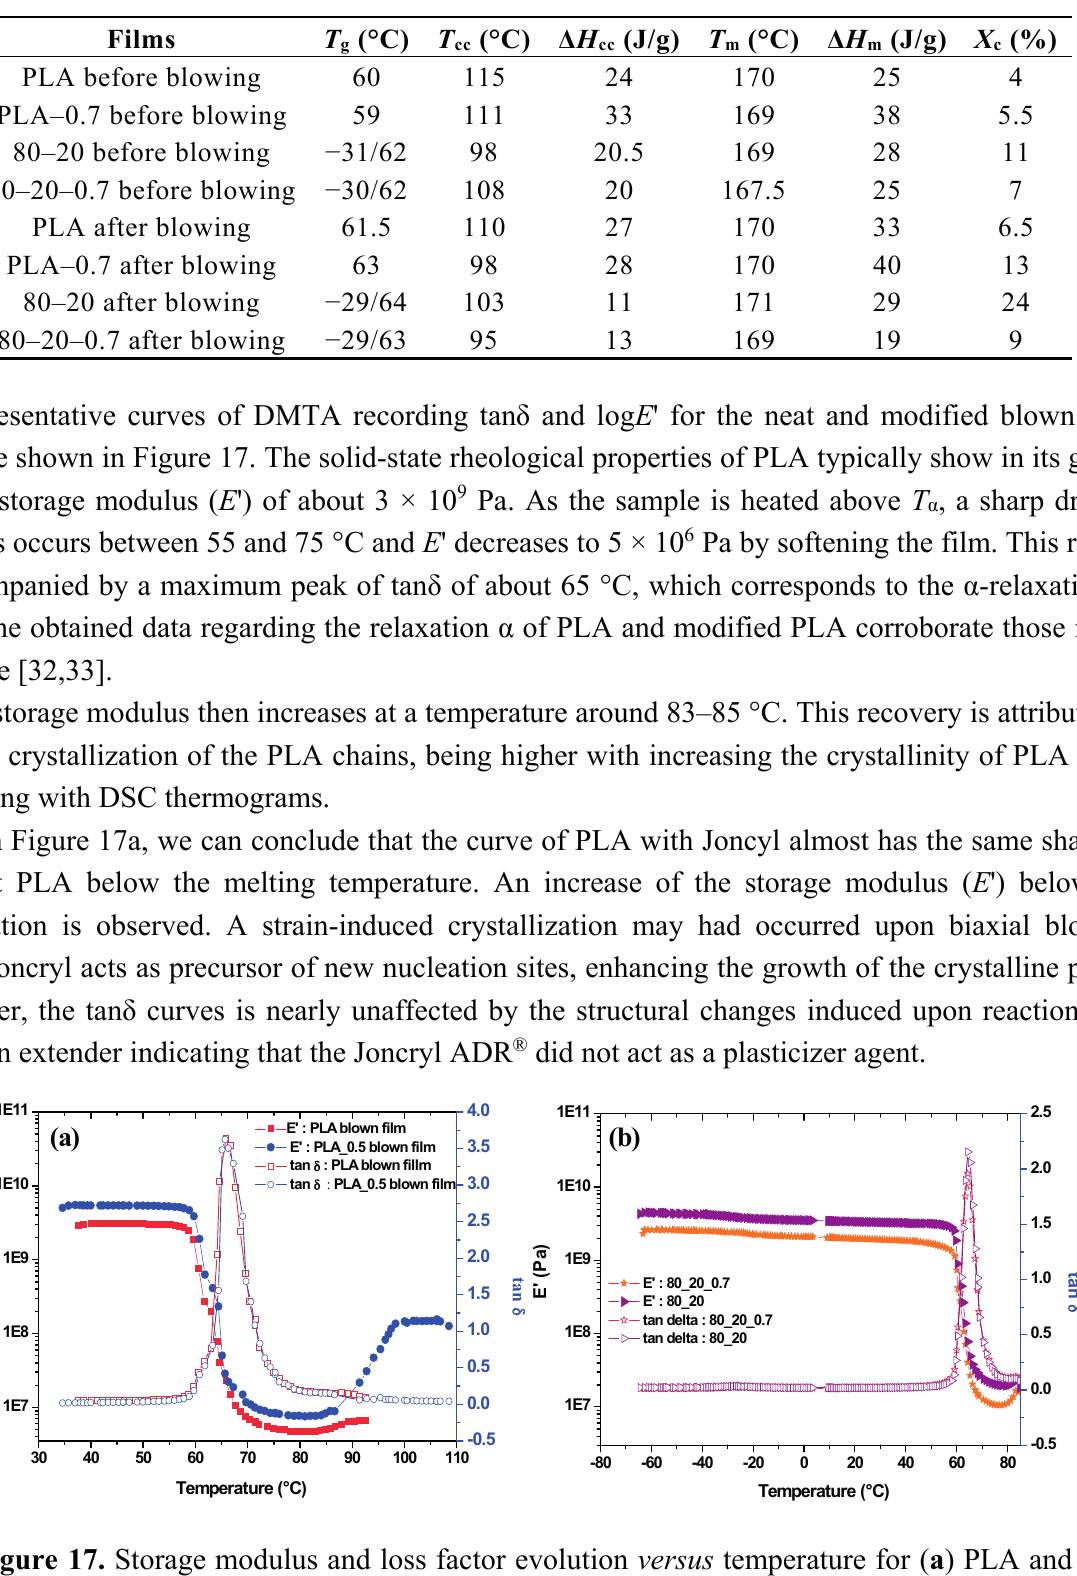
Table 2. Thermal parameters and crystallinity values of unblown and blown systems.